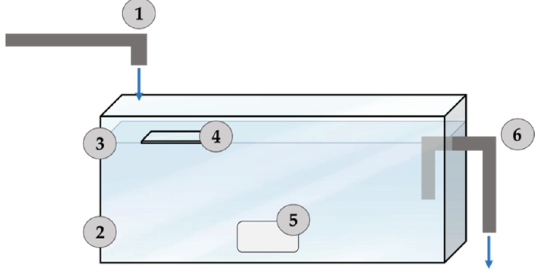
Figure 18. Hydraulic-engineering scheme of the experimental microcosms in use. (1) Water loading system (5 Lh − 1 ); (2) Experimentation tank; (3) Experimental water level (90 L); (4) study slides; (5)